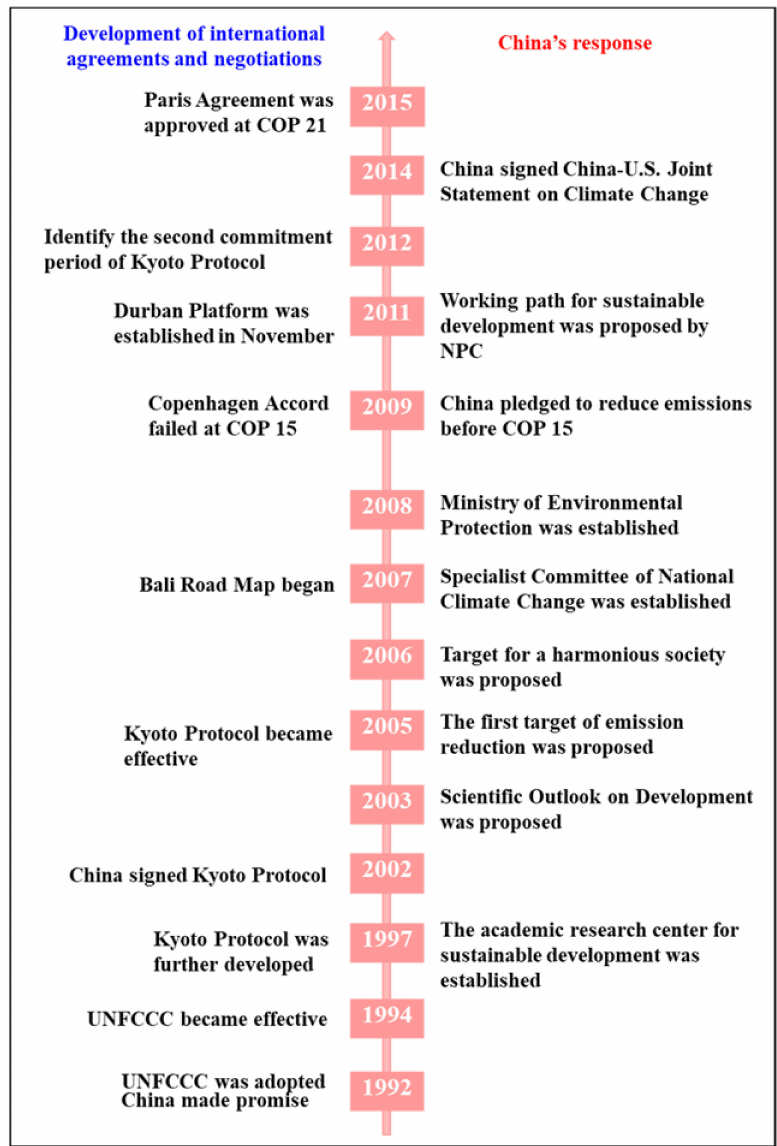
Figure 5. China’s policy response to international agreements and negotiations (Source: Compiled by